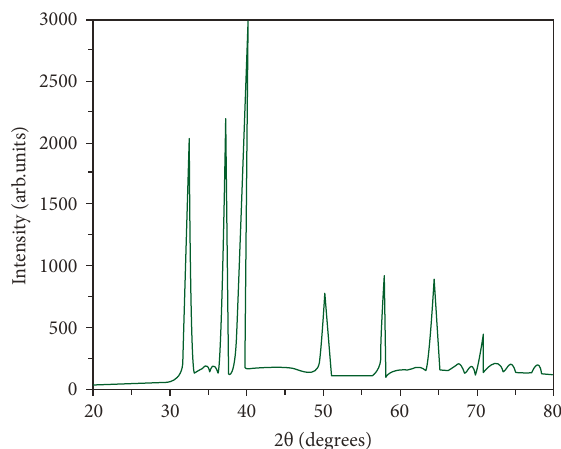
Figure 2: XRD image of room-temperature TiC NPs.